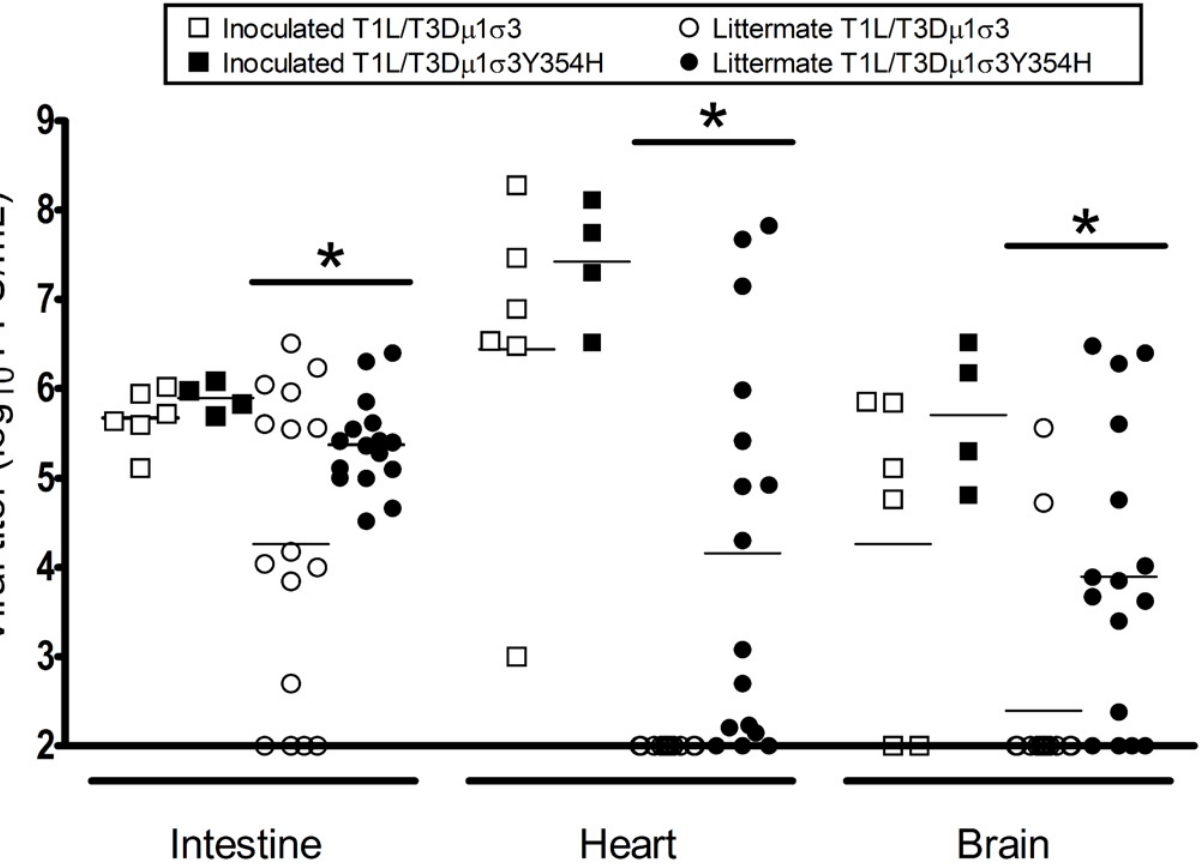
Fig 8. The σ 3-Y354H mutation is associated with higher viral loads after transmission of reovirus between littermates. Two newborn C57BL/6J mice from a litter of eight animals were inoculated perorally with 10 4 PFU of either T1L/T3D μ 1 σ 3 (black) or T1L/T3D μ 1 σ 3Y354H (white). The inoculated mice (squares) were placed with their uninoculated littermates (circles) and housed together. Eight days later, inoculated mice and uninoculated littermates were euthanized, intestine, heart, and brain were excised, and viral titers were determined by plaque assay. Results are expressed as viral titers for each animal assayed. * , P < 0.05 as determined by Mann-Whitney test in comparison to T1L/T3D μ 1 σ